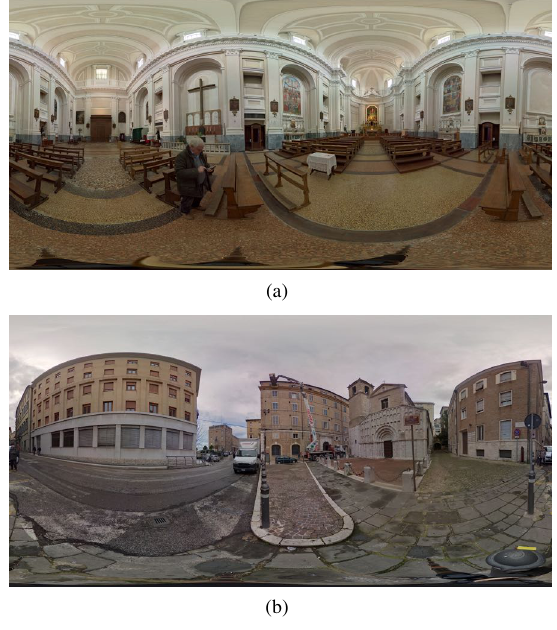
Figure 2. Two examples of Panoramas collected with the Panono 360. (a): San Francesco interior. (b): Santa Maria della Piazza